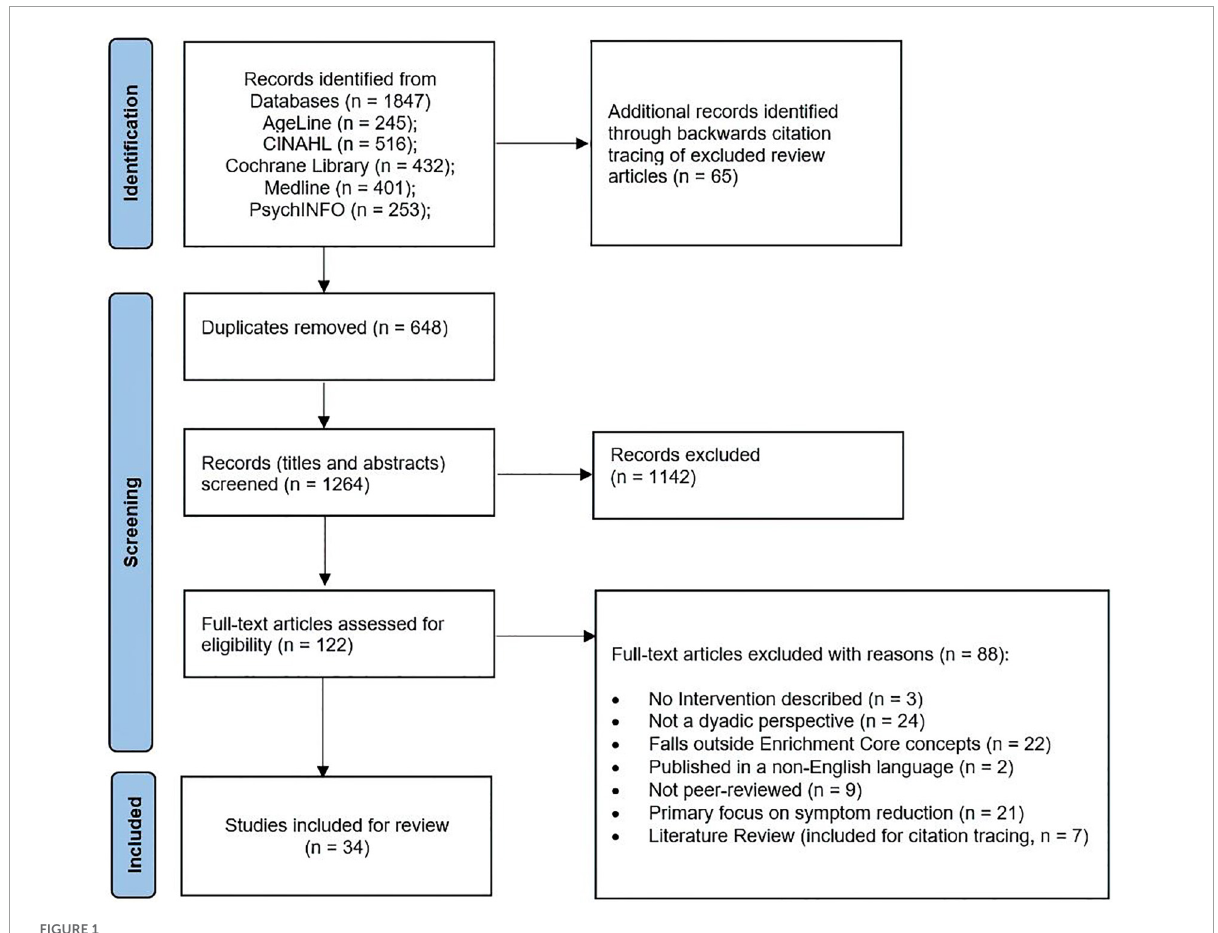
FIGURE1 PRISMA flow